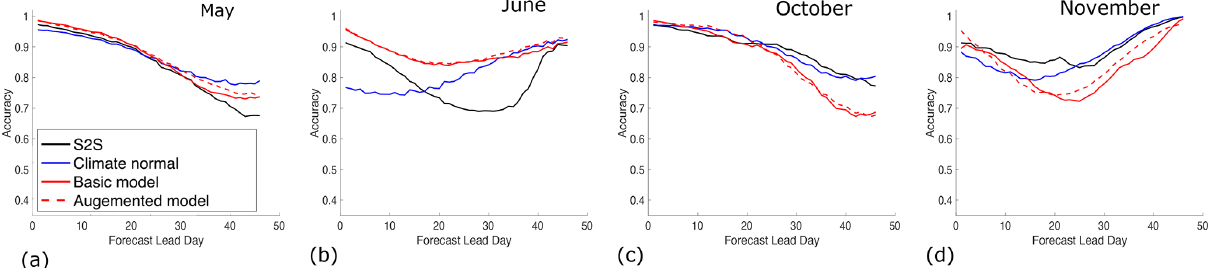
Figure 13. Binary accuracy as a function of lead day for forecasts launched in (a) May, (b) June, (c) October, and (d) November. These months were chosen because they display the largest differences between the various forecasting methods. Binary accuracies are evaluated using data from both 2016 and